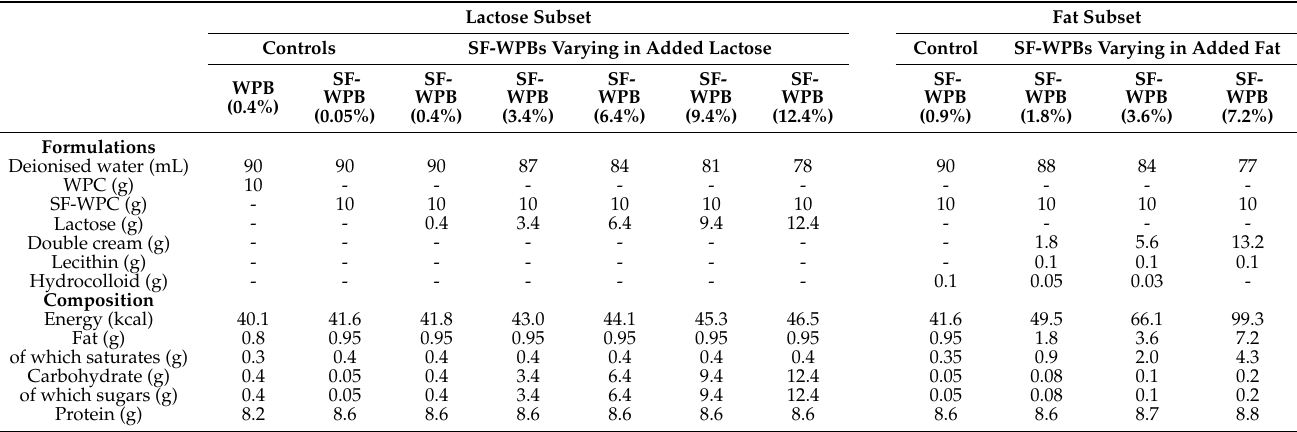
Table 1. Overview of whey protein liquid model lactose and fat subset (WPB: whey protein beverage; SF-WPB: sugar-free whey protein beverage).